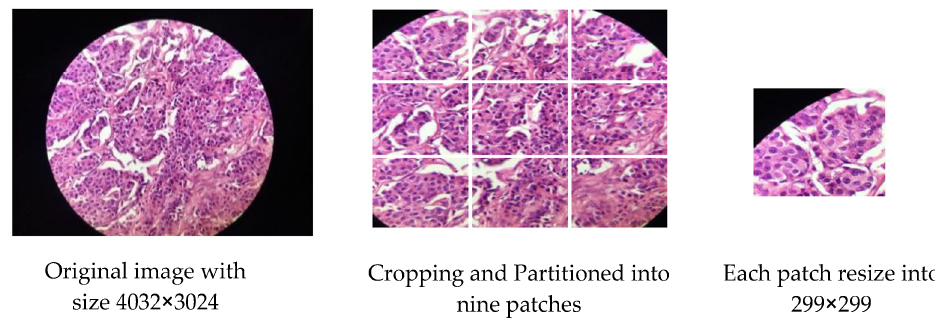
Figure 7. Example for Partitioning and resizing a BreakHis dataset.